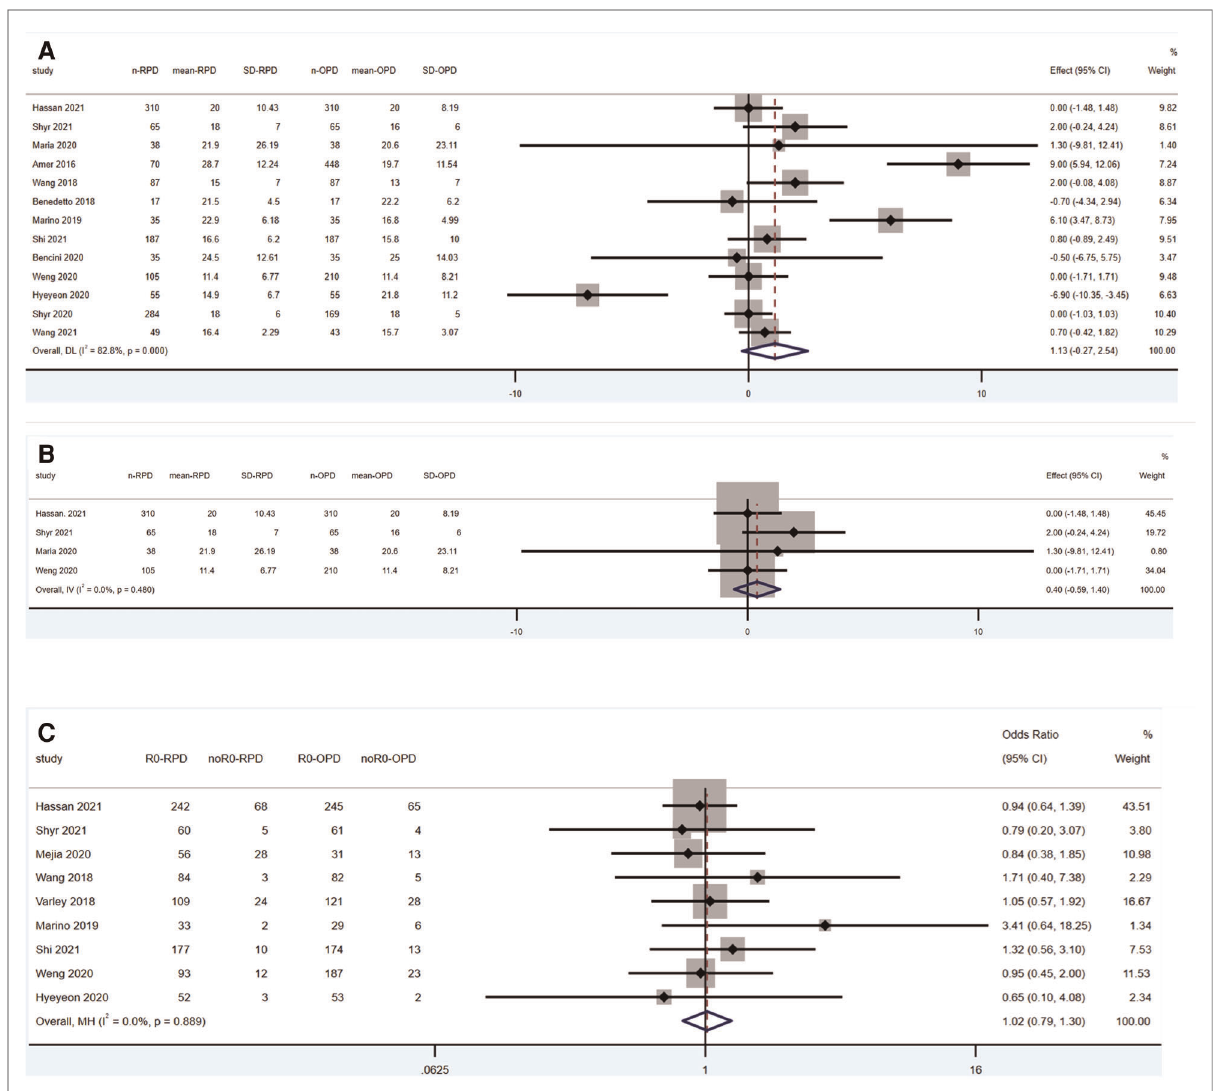
FIGURE 3 Meta-analysis of oncological outcomes: ( A ) lymph nodes harvested. ( B ) Lymph nodes harvested (in pancreatic cancer). ( C ) R0